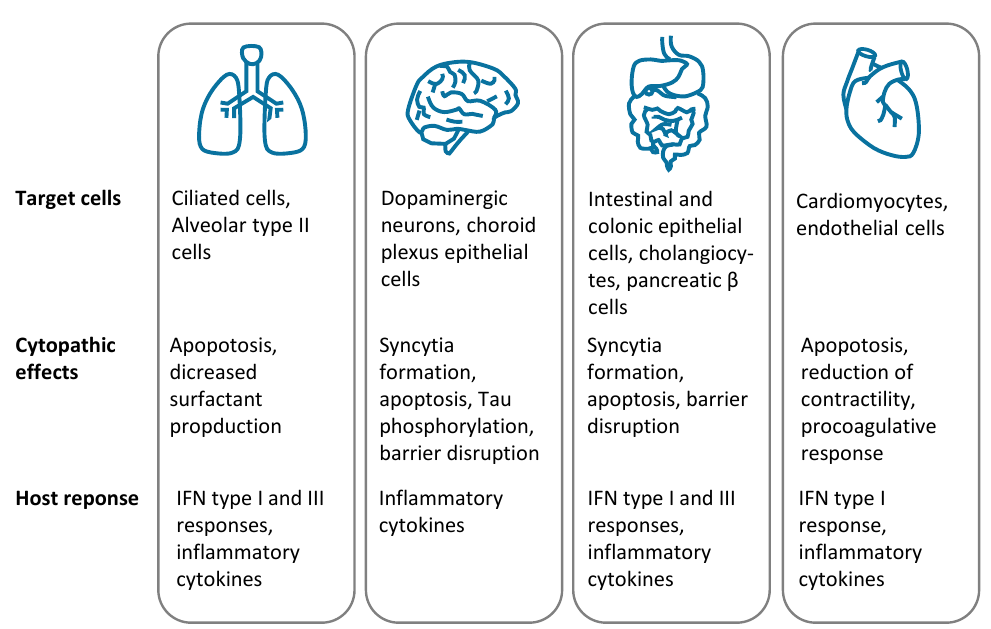
Figure 4. Modelling organ infection by SARS-CoV-2: SARS-CoV-2 infection of human lung epithelia, central nervous system, gastrointestinal tract, and cardiovascular system has been investigated by using stem cell technology and organoids. The architecture and physiology of different tissues and organs can be recapitulated in human 2D and 3D cultures of differentiated cells and organoids. These in vitro cell systems are generated from induced pluripotent stem cells (iPSCs), primary cells, cell lines and ex vivo tissue biopsies. Co-culture with immune cells allows to investigate the complex interplay with host inflammatory and immune response. The results of studies published in the literature, which demonstrated the potential of these in vitro models to dissect viral tropism and host cell response, are summarized in the figure.